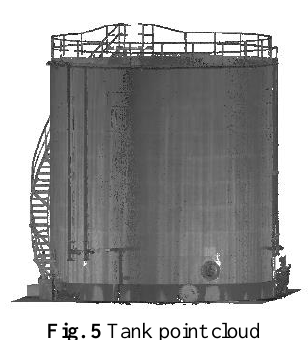
Fig. 5 Tank point cloud